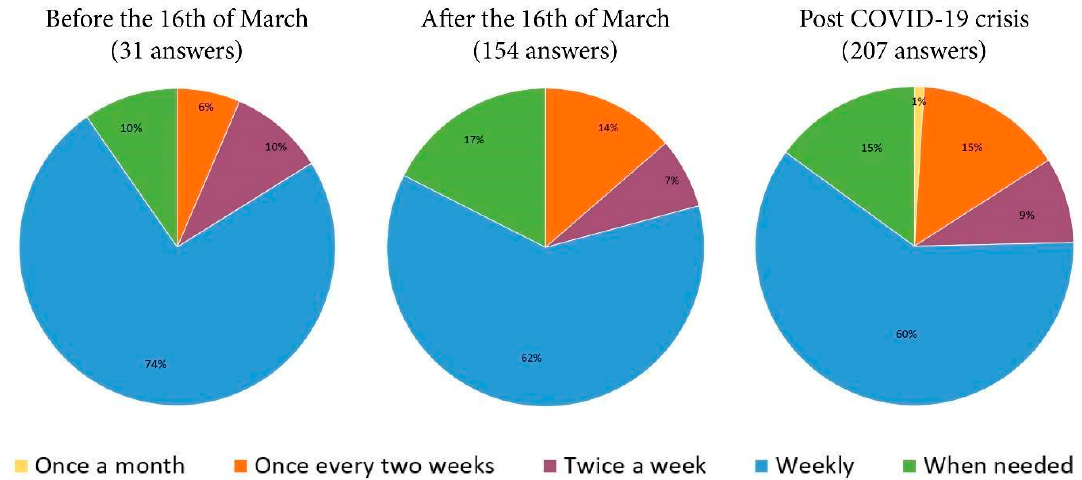
Figure 10. The order frequency on the clusters of the respondents who have stated that they bought fresh vegetables directly from producers before and after March 16 and that they will keep buying post COVID-19 crisis.